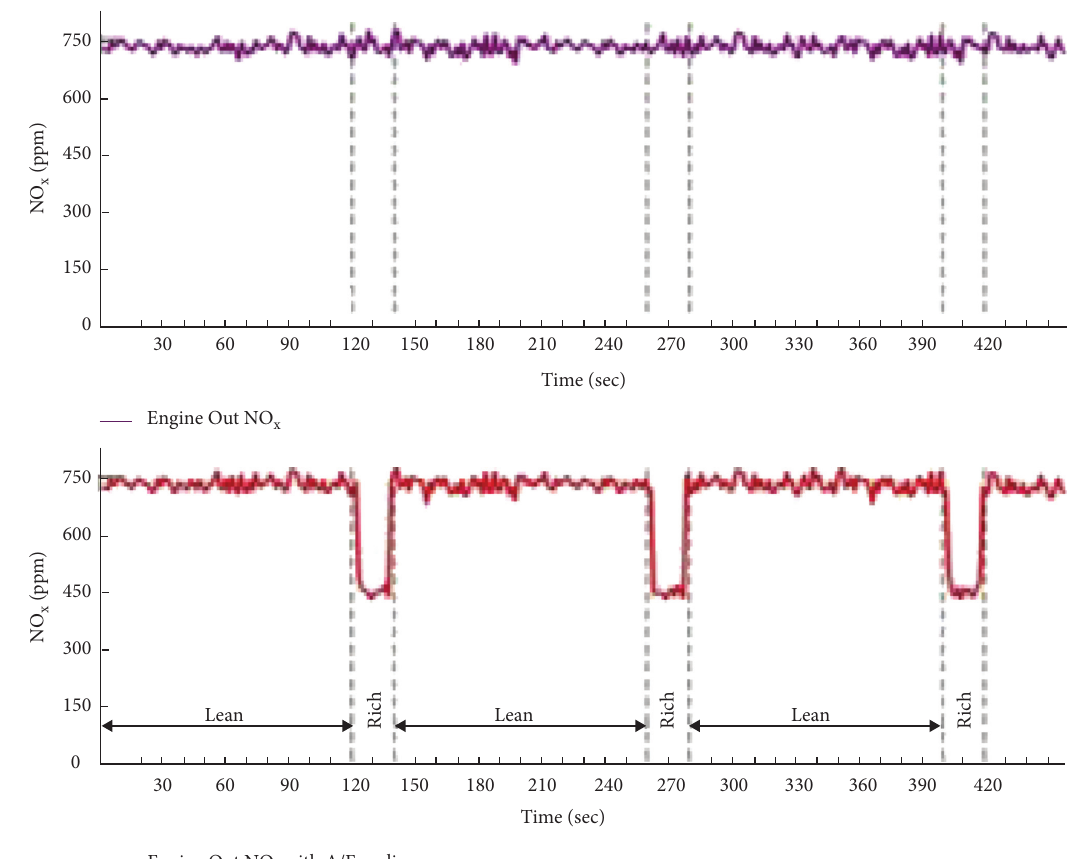
Figure 17: Engine-Out NO